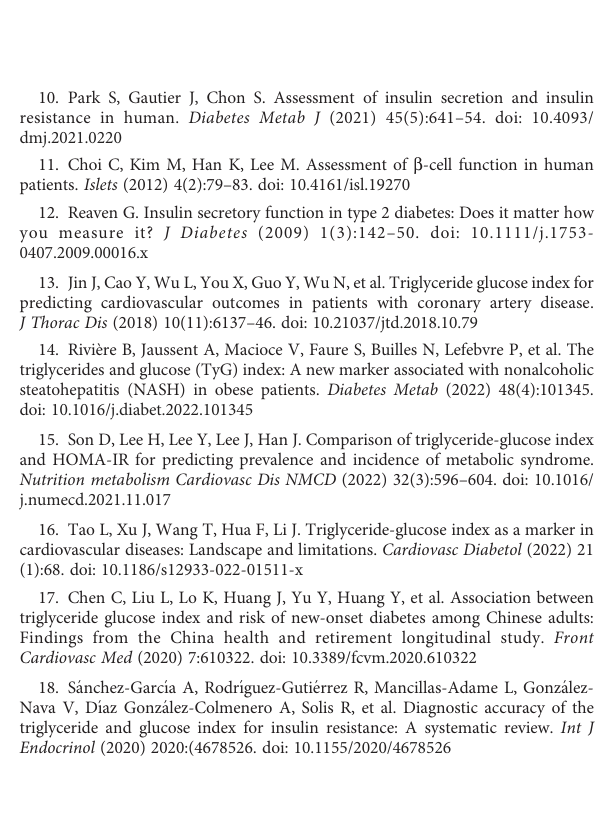
SUPPLEMENTARY TABLE 1 AUCs of theadjusted ROC for TyGin predicting b -cell dysfunction. a: Age, Gender, SBP, DBP, HbA1C, HDL, FINS, FCP